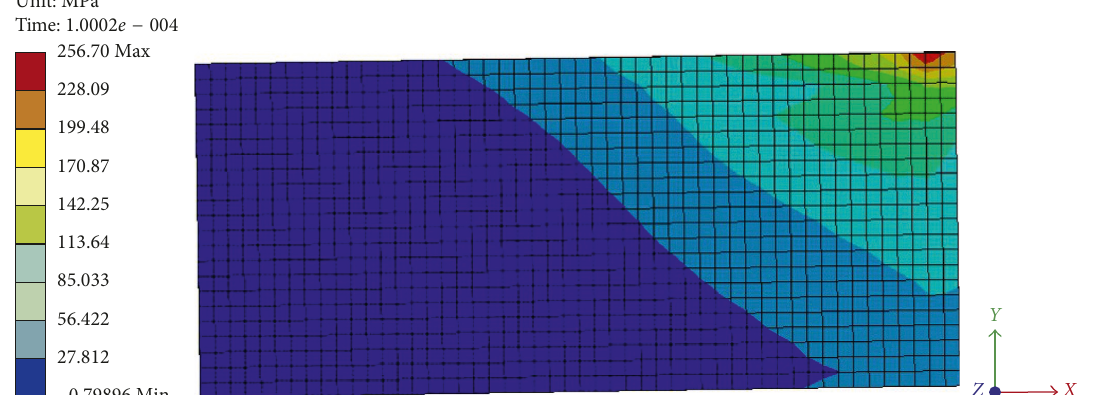
Figure 9: Map of Max Principal Stress distribution in the joint for the computational time equal to 0.0001s, sample rotated against the impactor at angle of 3 ° .